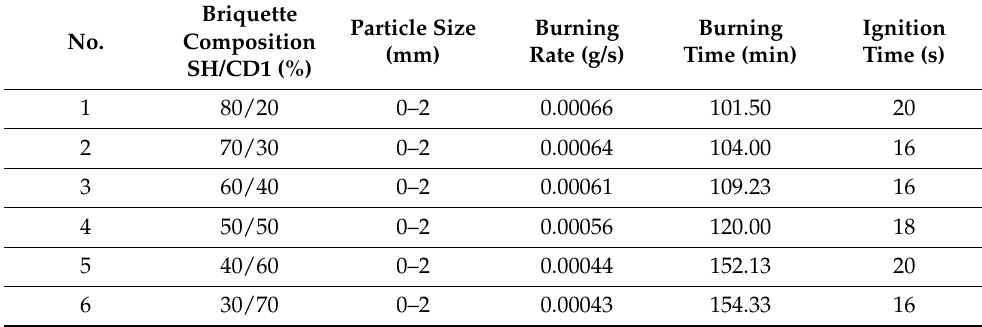
Table 9. The result of burning rate, burning time and ignition (leaves and Karazhyra coal dust).